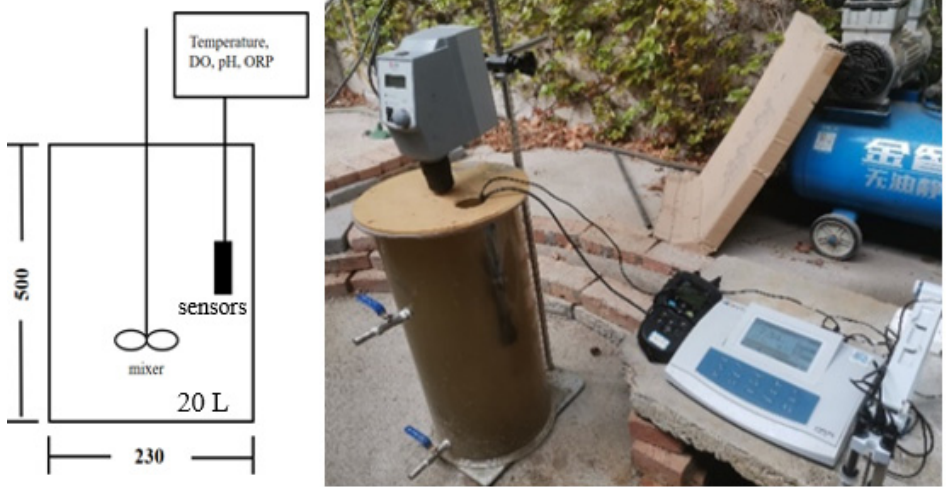
Figure 2. Schematic diagram of the experimental setup for the study of ORP correlation with water quality.